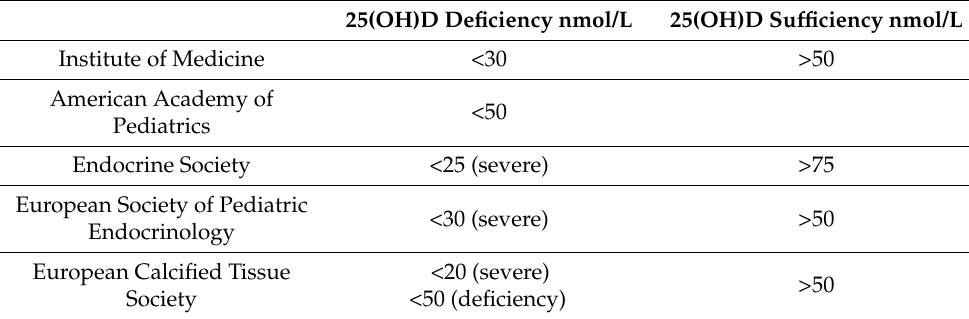
Table 1. Calcifediol (25(OH)D) status definition according to different organisations and scientific societies (adapted from [5]); to convert to ng/mL, divide by